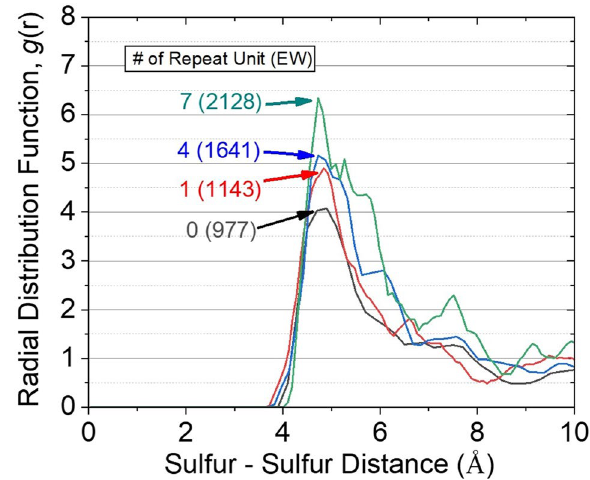
Figure 4. Radial distribution function (RDF) of sulfur–sulfur for the membrane with various length of side chains. The first peak for RDF of sulfur at the end of the longest side chain is 1.5 times higher than that of the shortest.